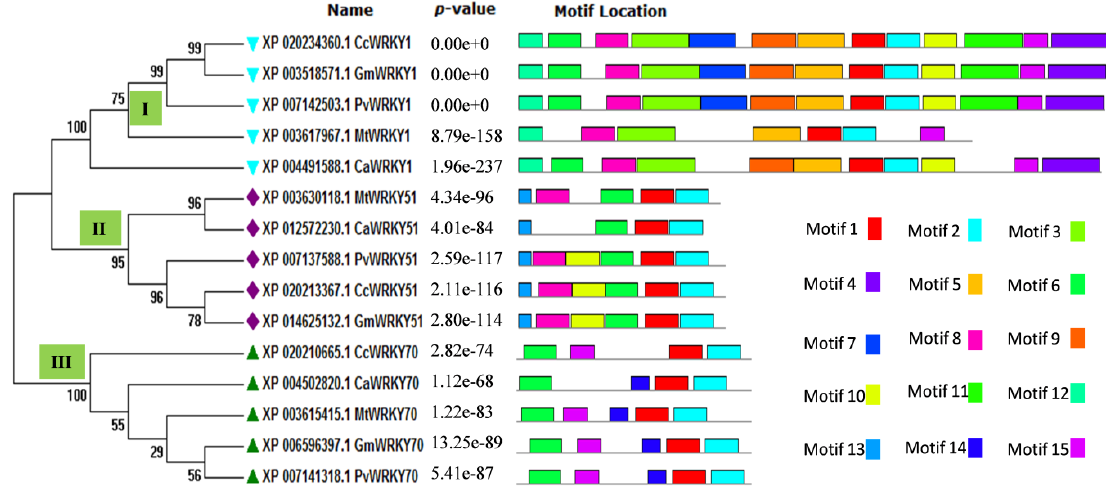
Figure 2. Distribution of conserved motif in respect to the phylogenetic grouping of WRKY transcriptions factor belongs to Cajanus cajan (Cc), Cicer arietinum (Ca), Medicago truncatula (Mt), Glycine max (Gm), and Phaseolus vulgaris (Pv) . The illustration shows the distribution of fifteen predicted conserved motifs in CcWRKY groups. The phylogenetic tree was constructed using the Maximum Likelihood (ML) method with 1000 bootstrap replicates.